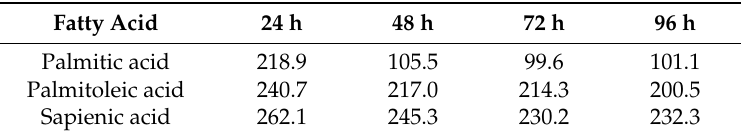
Table 1. Fatty acid EC 50 ( µ M) estimated on Caco-2 cell viability after the indicated incubation times. EC 50 is the concentration of fatty acid required to reduce Caco-2 cell viability by 50%, calculated by linear regression. Viability was evaluated measuring tetrazolium salt